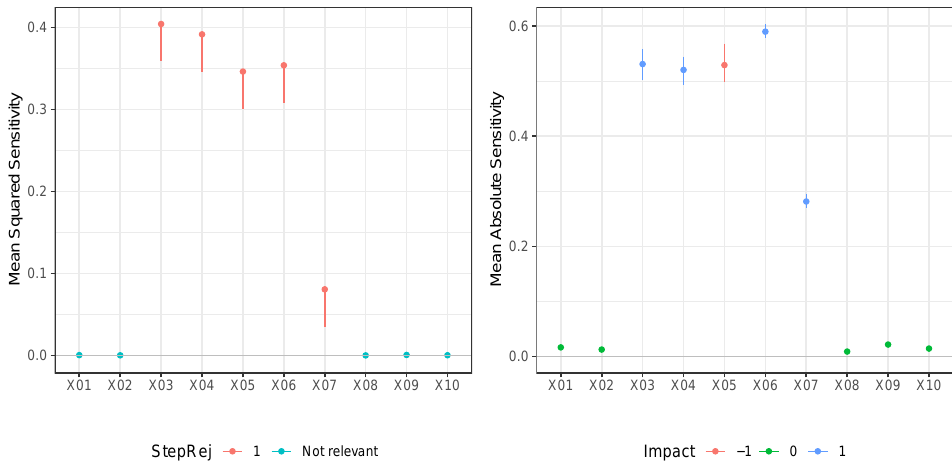
Figure 6. Model M3 (Friedman). Case n = 1000. ( left ) Values of test statistic T n and critical values T n − ˆ c ( 1 − α , k ) . ( right ) Values of mean absolute sensitivity along with bootstrap confidence limits with B = 1999 bootstrap replicates and nominal level 1 − α = 0.90, for relevant variables to the